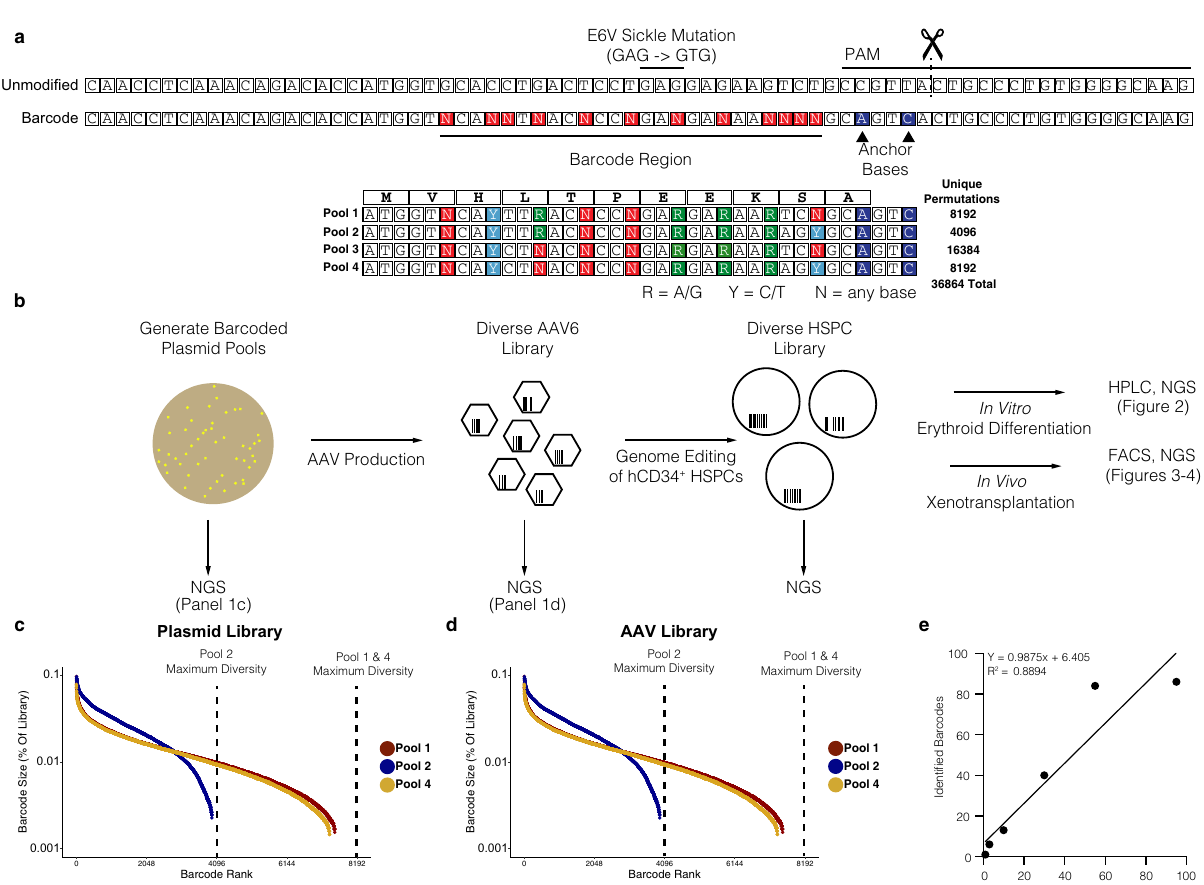
Fig. 1 Design and production of barcoded AAV6 donors for long-term genetic tracking of gene-targeted cells and their progeny. a Schematic of HBB targeting strategy. Top: Unmodi fi ed (WT) and barcoded HBB alleles depicted, with location of the E6V (GAG - > GTG) sickle cell disease mutation and CRISPR/Cas9 target sites labeled. Bottom: β -globin ORF translation with four barcode pools representing all possible silent mutations encoding amino acids 1-9. b Schematic of barcode library generation and experimental design. c/d Percentages of reads from each valid barcode identi fi ed through amplicon sequencing of plasmids ( c ) and AAV ( d ) pools 1, 2, and 4. e Recovery of barcodes from untreated genomic DNA containing 1, 3, 10, 30, and 95 individual plasmids containing HBB barcodes. Expected number of barcodes is plotted against the number of barcodes called by the TRACE-seq pipeline after fi